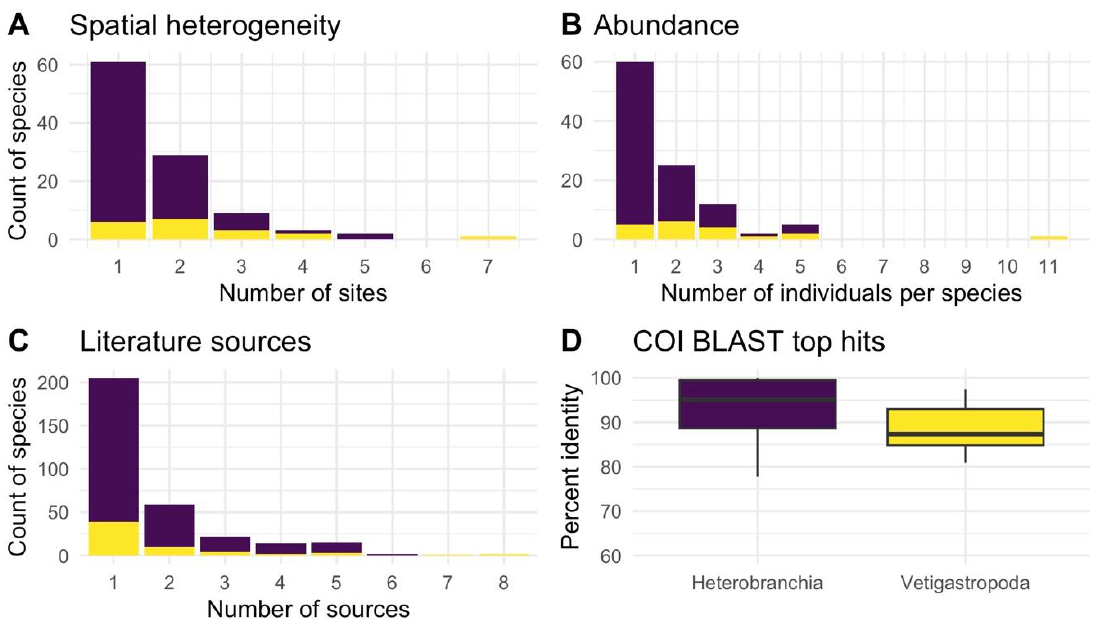
Figure 2. Distribution of species of Heterobranchia (purple) and Vetigastropoda (yellow) by ( A ) the number of sites where they were collected, ( B ) the number of specimens, and ( C ) the number of literature sources where the species is recorded. ( D ) Percent identity of the best BLAST hit for all barcoded specimens. Table 1. Checklist of heterobranch and vetigastropod species found in the Maldives, including new species and undetermined species ( sensu Gosliner et al. [23] for heterobranchs). Species collected in this study are highlighted in bold, figure citations are included. Species names recorded from the literature were updated according to WoRMS [18] unless explicitly discussed in the source refer- ence. From the OBIS database [33] , only records with ‘ preserved specimens ’ were considered.